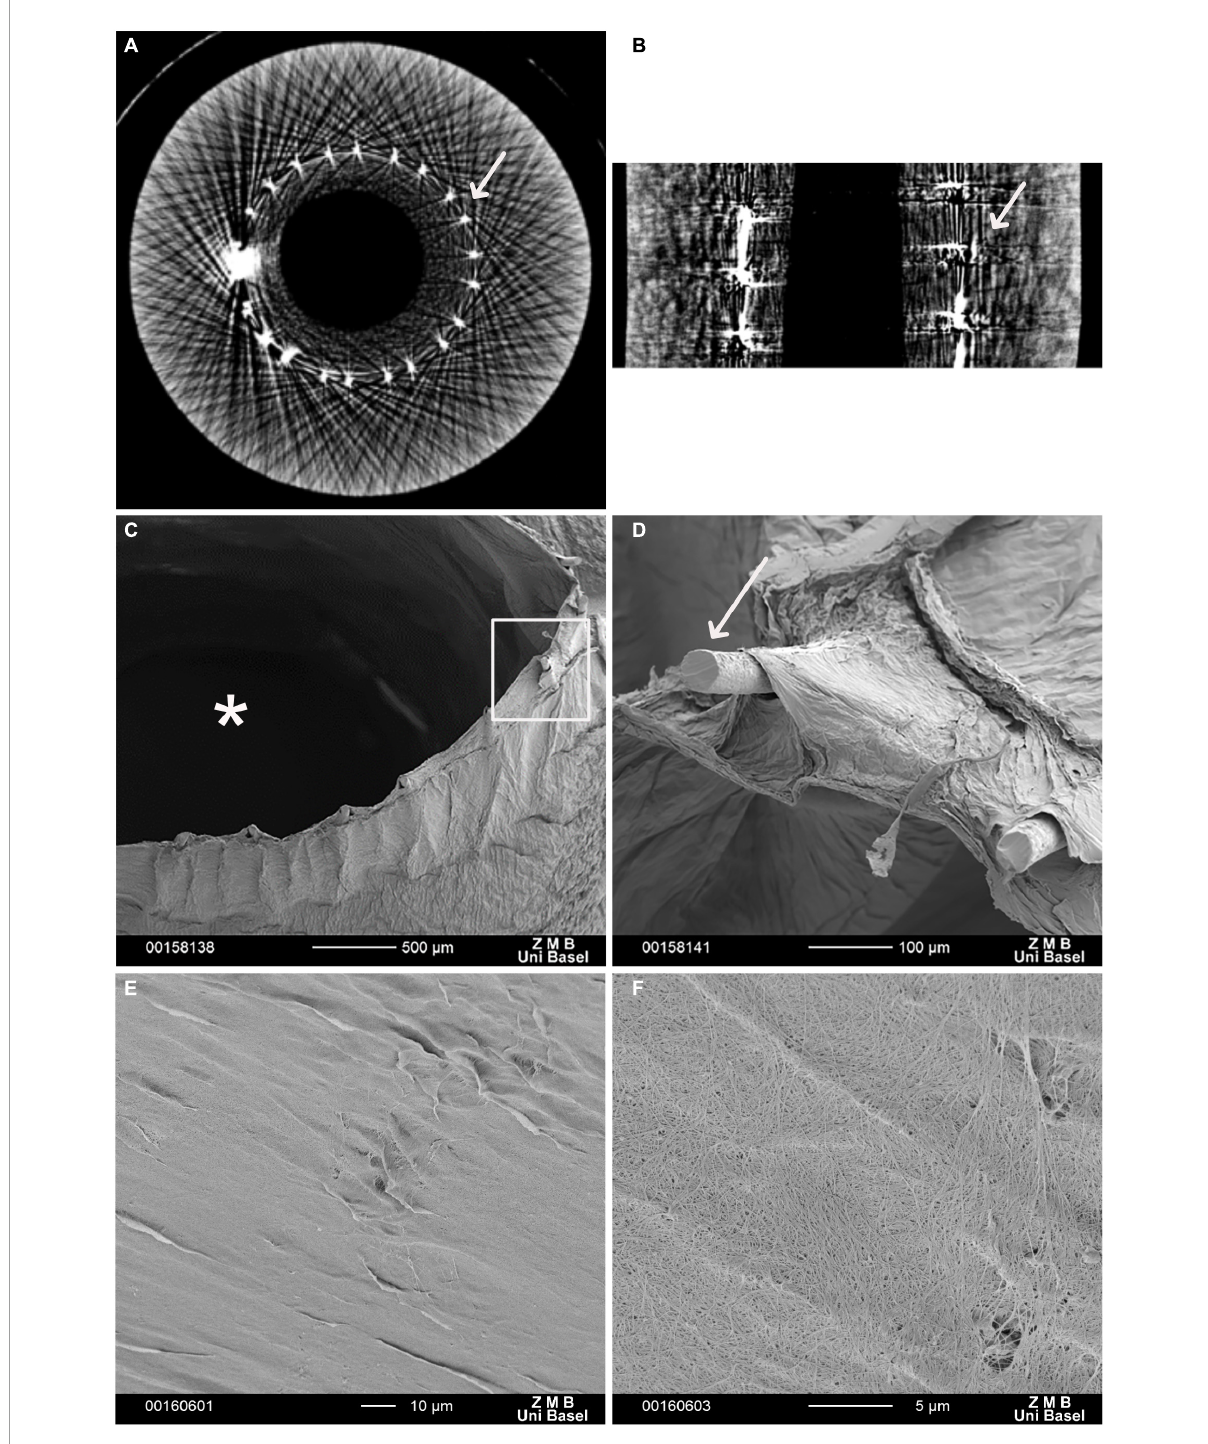
FIGURE1 Electron microscopy of a vascular graft. Micro-computed tomography (Micro-CT) scan. (A) Cross section, (B) longitudinal section of the reinforced bacterial cellulose (BC)-based vascular graft. White arrows indicate the Co-Cr mesh scanning electron microscopy (SEM). (C) In the cross-section, the structure of the graft comprising an inner BC layer defining the graft lumen (*), the embedded metallic mesh, and an outer BC layer is visible. (D) The enlargement (rectangular frame) shows the ends of the mesh wires (arrow). These protruding ends result from cutting and further processing of the vascular graft. (E,F) BC-vascular graft luminal surface. (F) At higher magnification, porosity of BC-vascular graft luminal